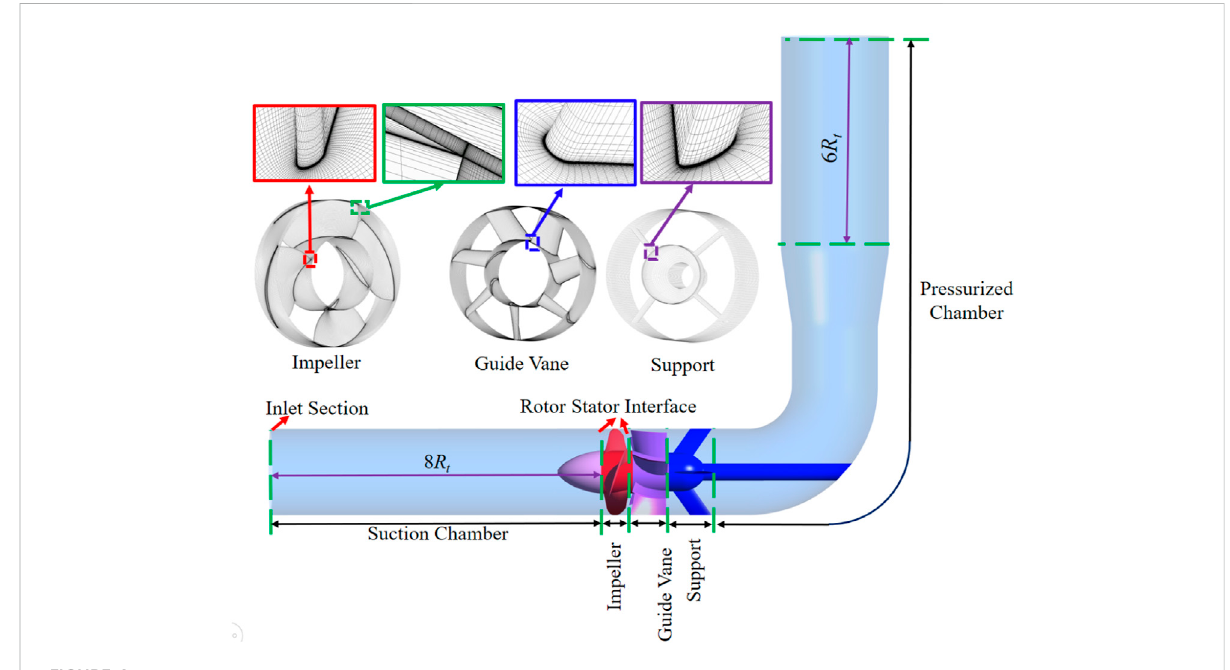
FIGURE 4 Flow domains and grids.